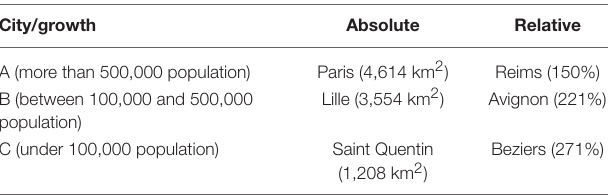
TABLE 1 | Cities with the highest urban development dynamics in France, by population class (in brackets: absolute and relative change of urban land).